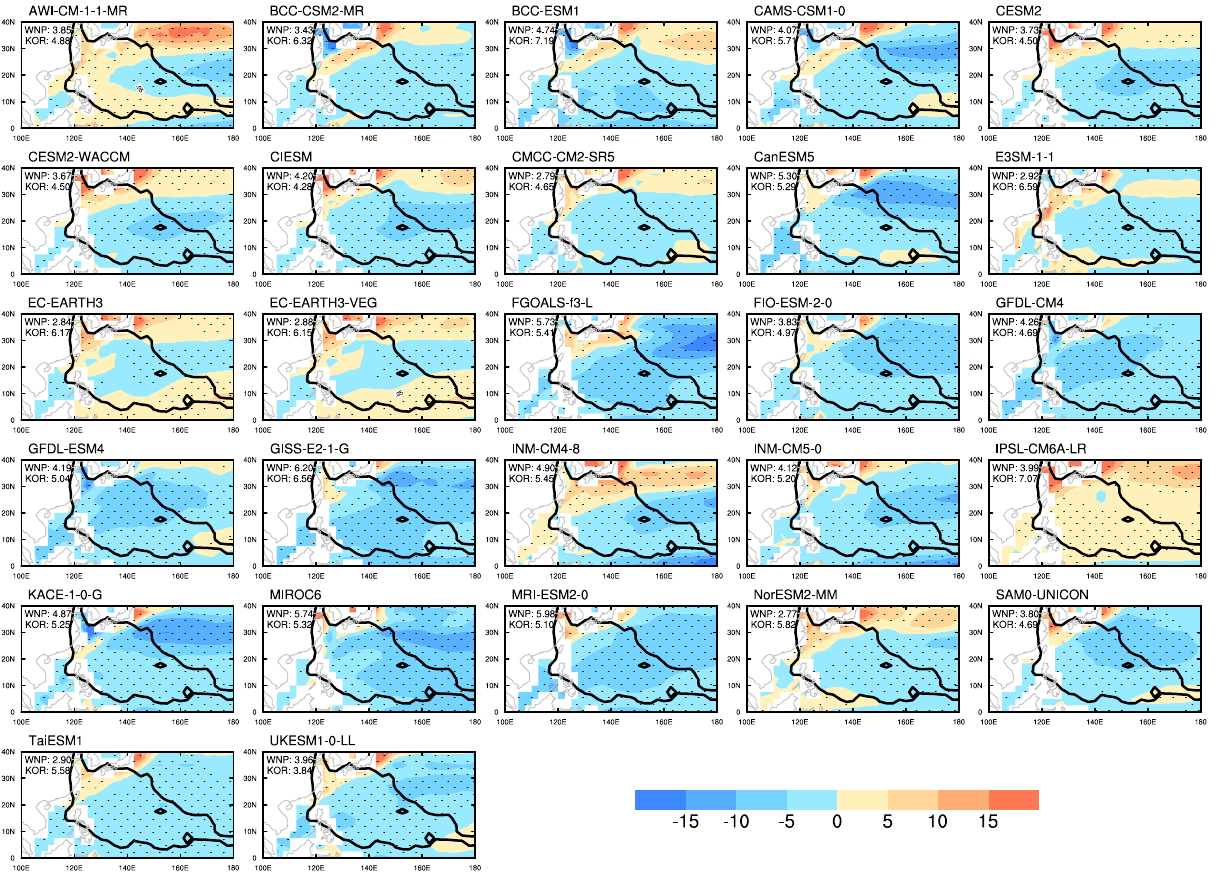
Figure 4. The same as Figure 3 but for CMIP6 models.